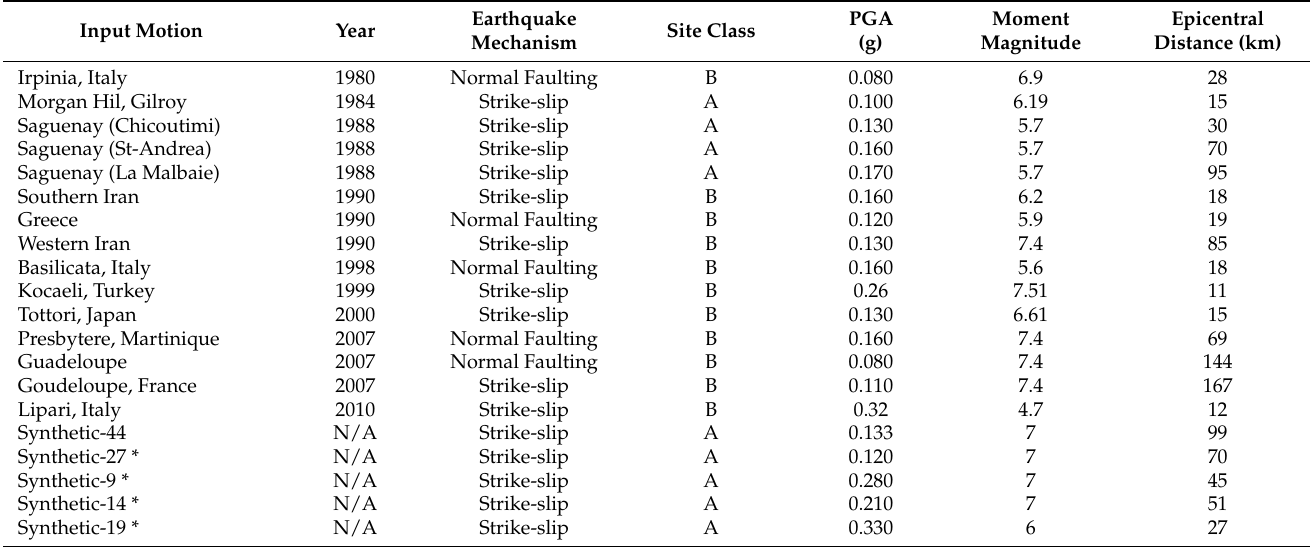
Table 1. Characteristics of ground input motions selected for the equivalent 1-D analysis in Montreal. Input